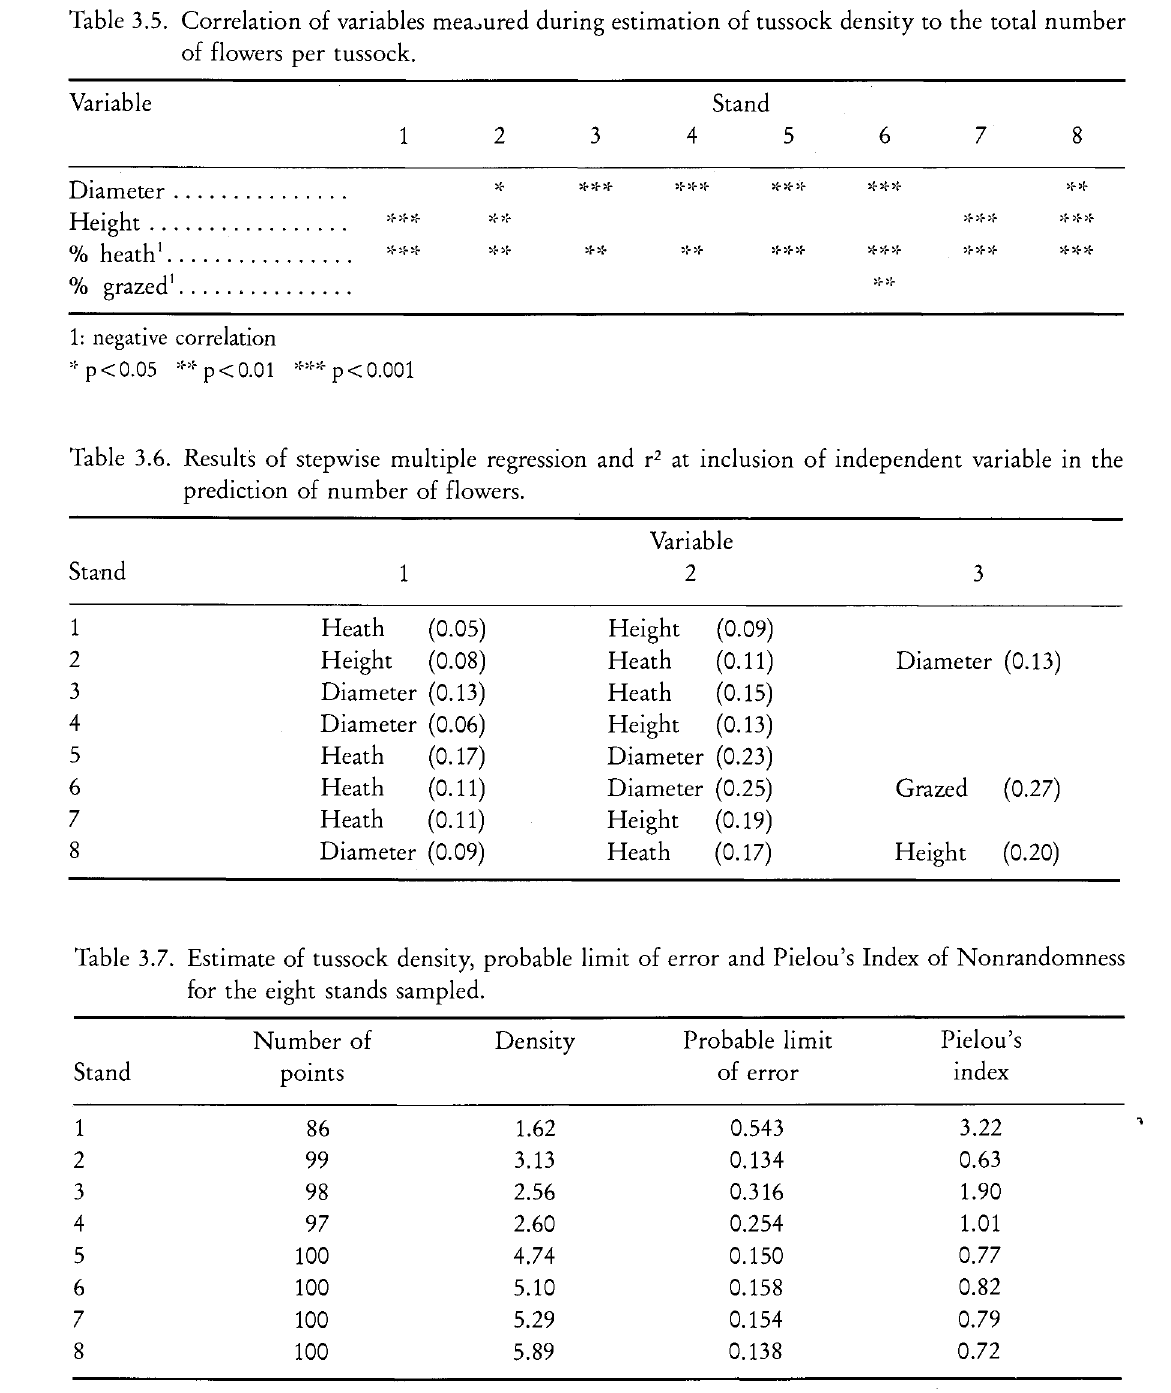
Table 3.7. Estimate of tussock density, probable limit of error and Pielou's Index of Nonrandomness for the eight stands